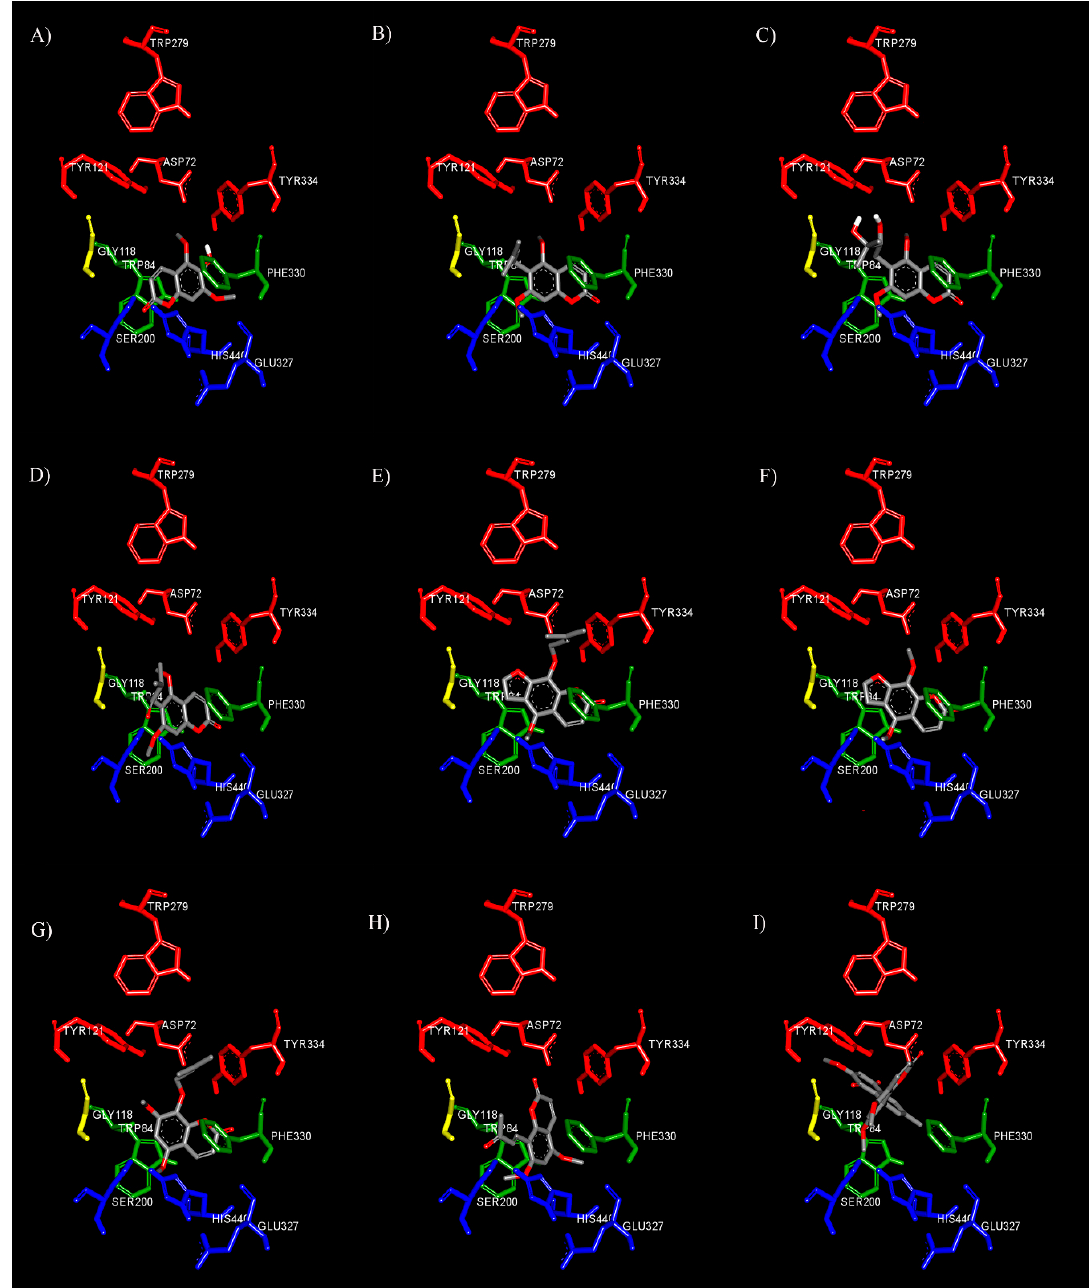
Figure 2. Binding mode of coumarin derivatives fraxinol ( A ), toddaculin ( B ), toddalolactone ( C ), toddanone ( D ), phellopterin ( E ), isopimpinellin ( F ), artanin ( G ), toddalenone ( H ), and toddacoumaquinone ( I ) at the binding site of AChE predicted by molecular docking. The active sites are coded with different colors (CAS; blue, AS; green, oxyanion hole; yellow, and PAS; red).